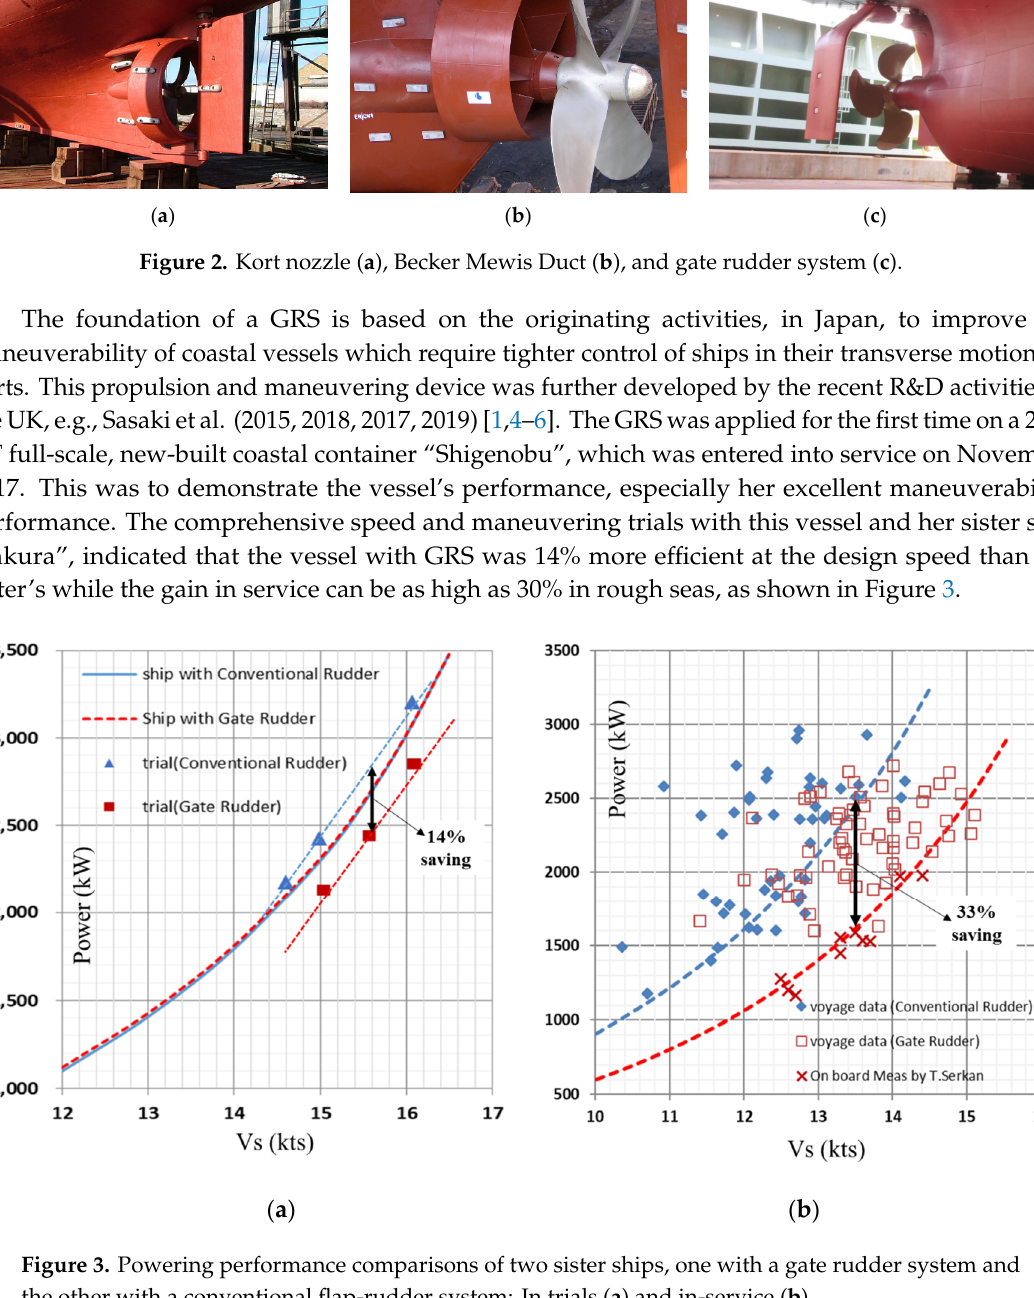
Figure 3. Powering performance comparisons of two sister ships, one with a gate rudder system and